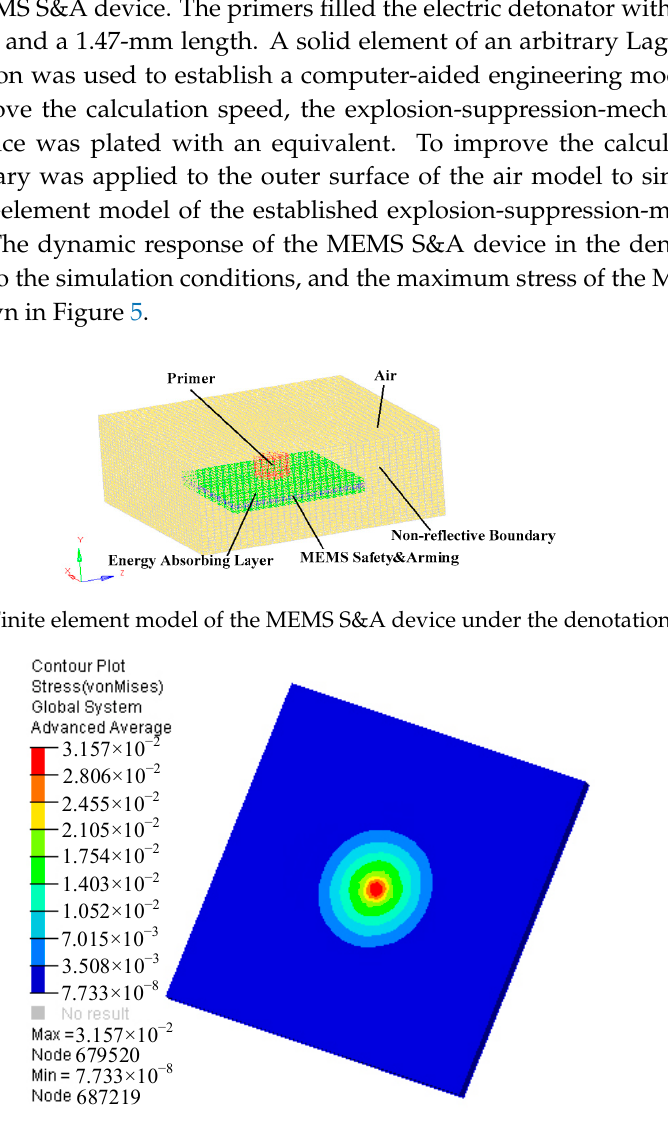
Figure 5. Maximum stress cloud of the MEMS S&A device.